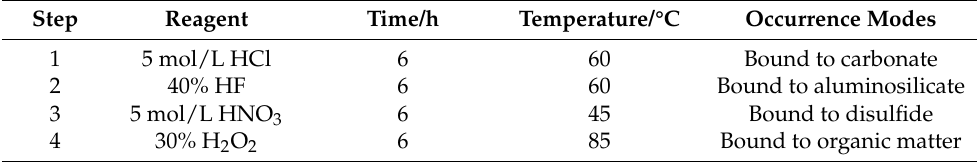
Table 4. Sequential chemical extraction